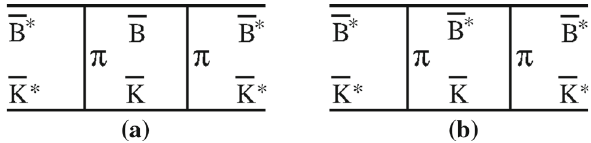
Fig. 7 Boxdiagrams fortheevaluationofthewidthofthe ¯ B ∗ ¯ K ∗